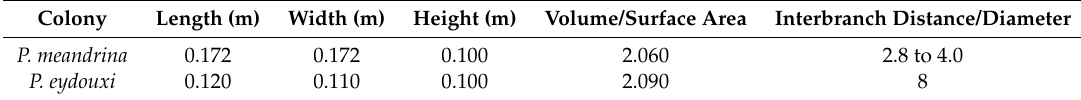
Table 1. Geometrical features of the Pocillopora